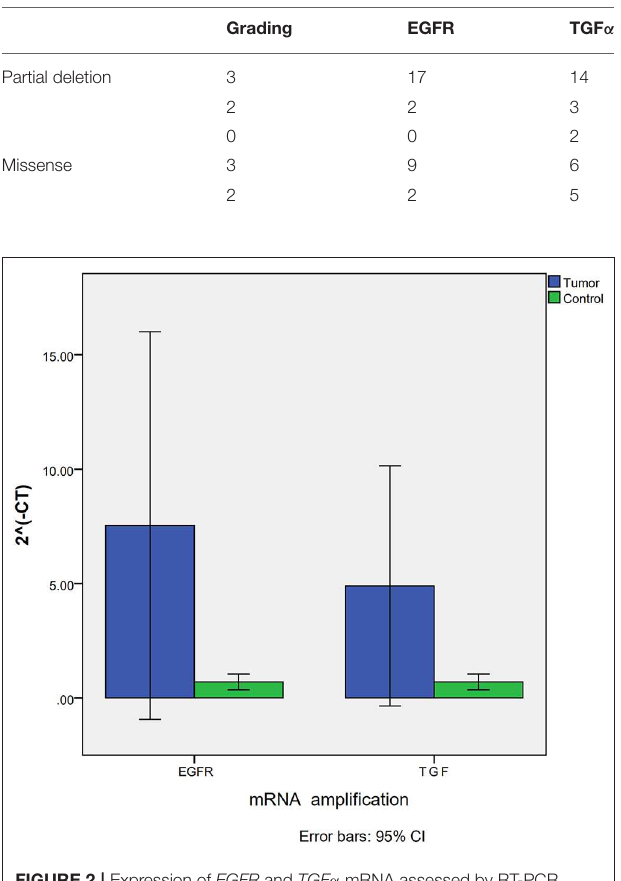
TABLE 1 | Immunohistochemistry score for EGFR and TFG α in different mutation groups.